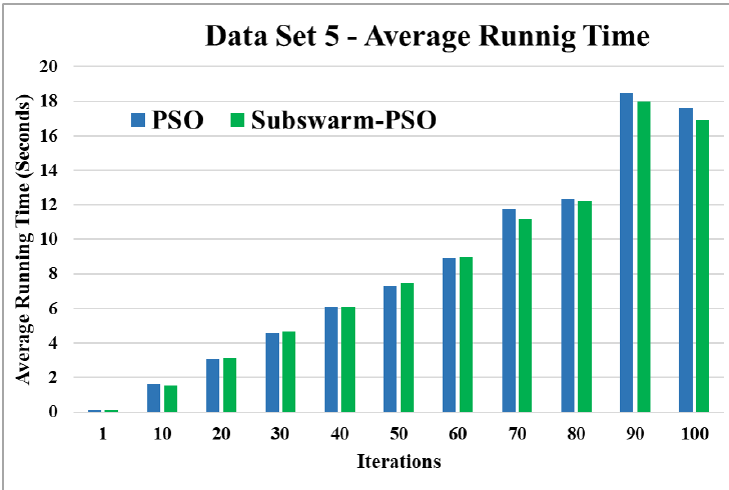
Figure 14. Average running time for data set 5.